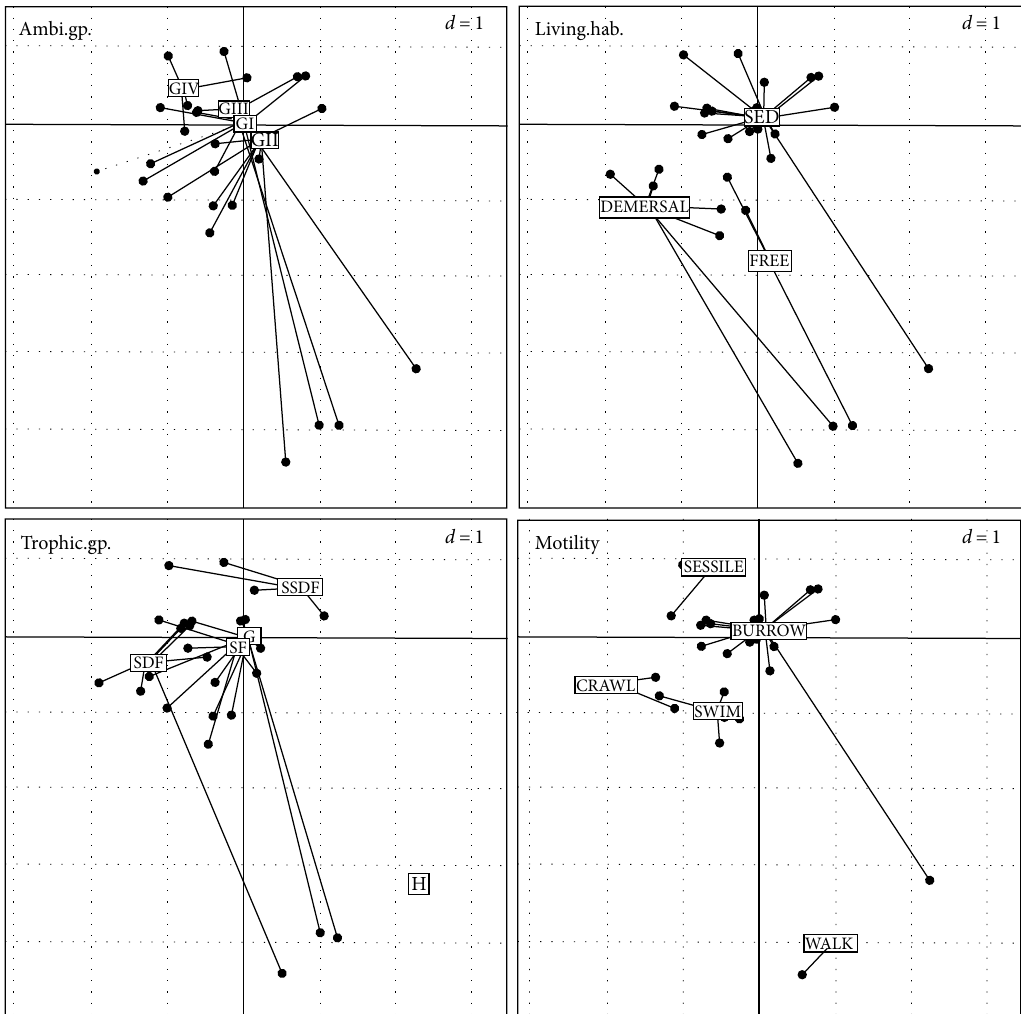
Figure 7: RLQ diagram as defined by the two axes with the projection of different trait categories. Different diagrams were created to simplify results visualization. The 𝑑 value in the upper right corner is the scale of the graph given by a grid. See Table 2 for the corresponding trait modalities